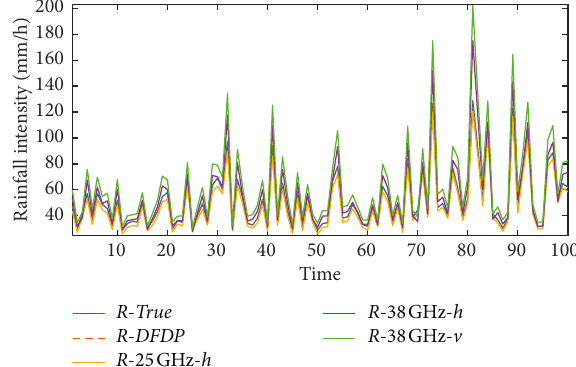
Figure 9: Retrieval results of R (second group).